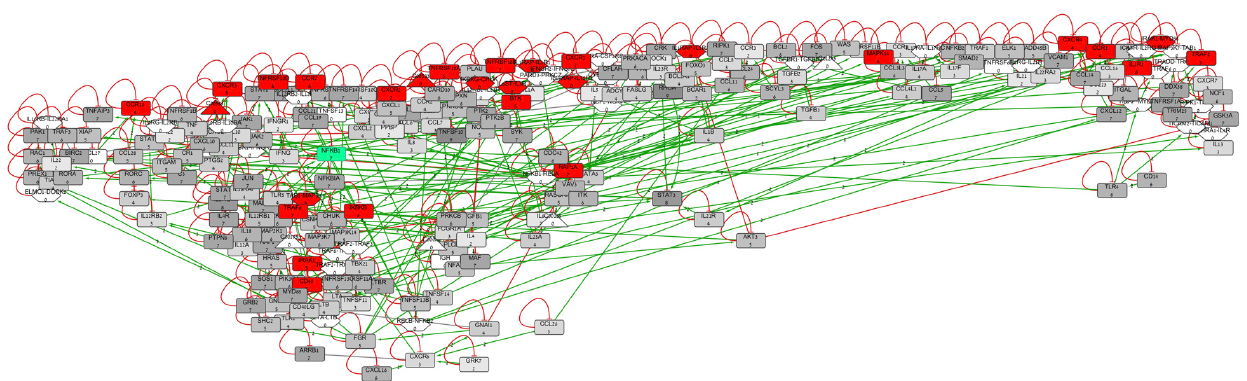
Figure 2. The main component of the CLDP test case network. We show only 241 out of 379 genes, which belong to the main connected subnetwork resulting from 7 KEGG pathways (excluding subnetworks of 8 nodes or less). We used Cytoscape’s hierarchical layout, in which nodes with no outgoing edges appear at the top. Gene’s fill color is according to control expression values (grayscale), except nodes that are different between the simulation of CLDP and control expression, which are marked in red, and NFKB1 which is colored turquoise. Edges are colored according to type of interaction (activation–green; inhibition-red). For convenience, genes or proteins are represented as rectangles, compounds as triangles and complexes (dimers) are